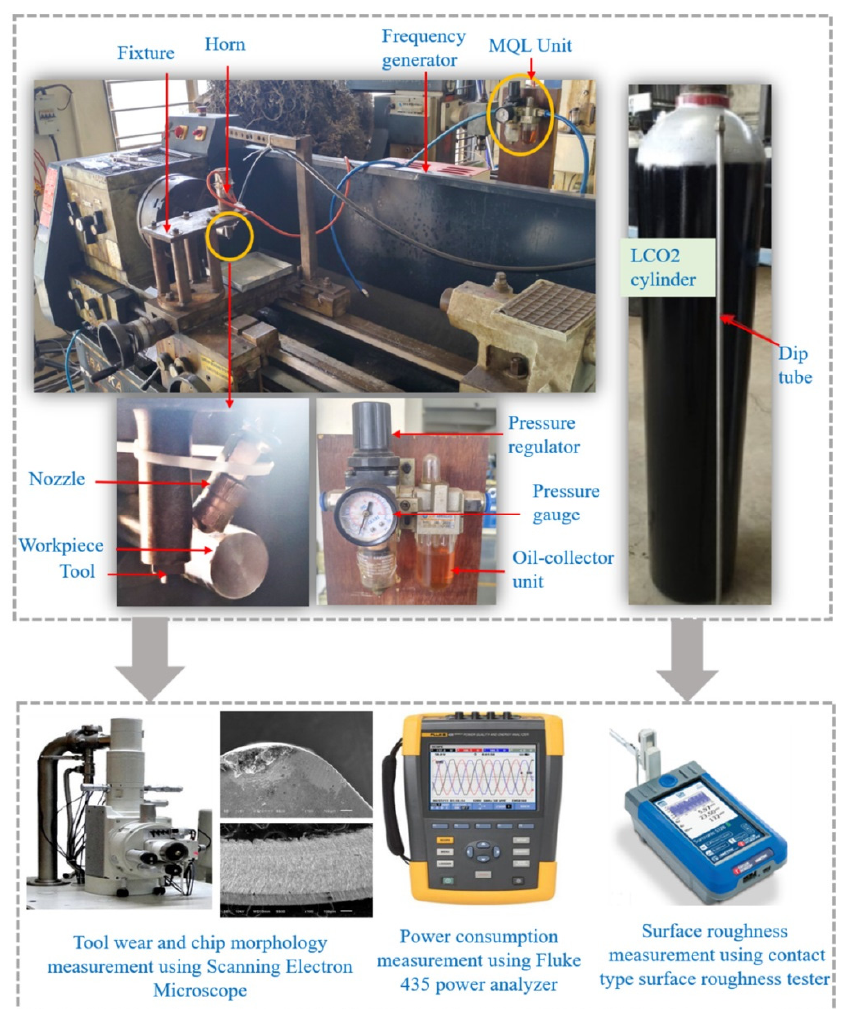
Figure 5. Experimental setup and followed plan [90].